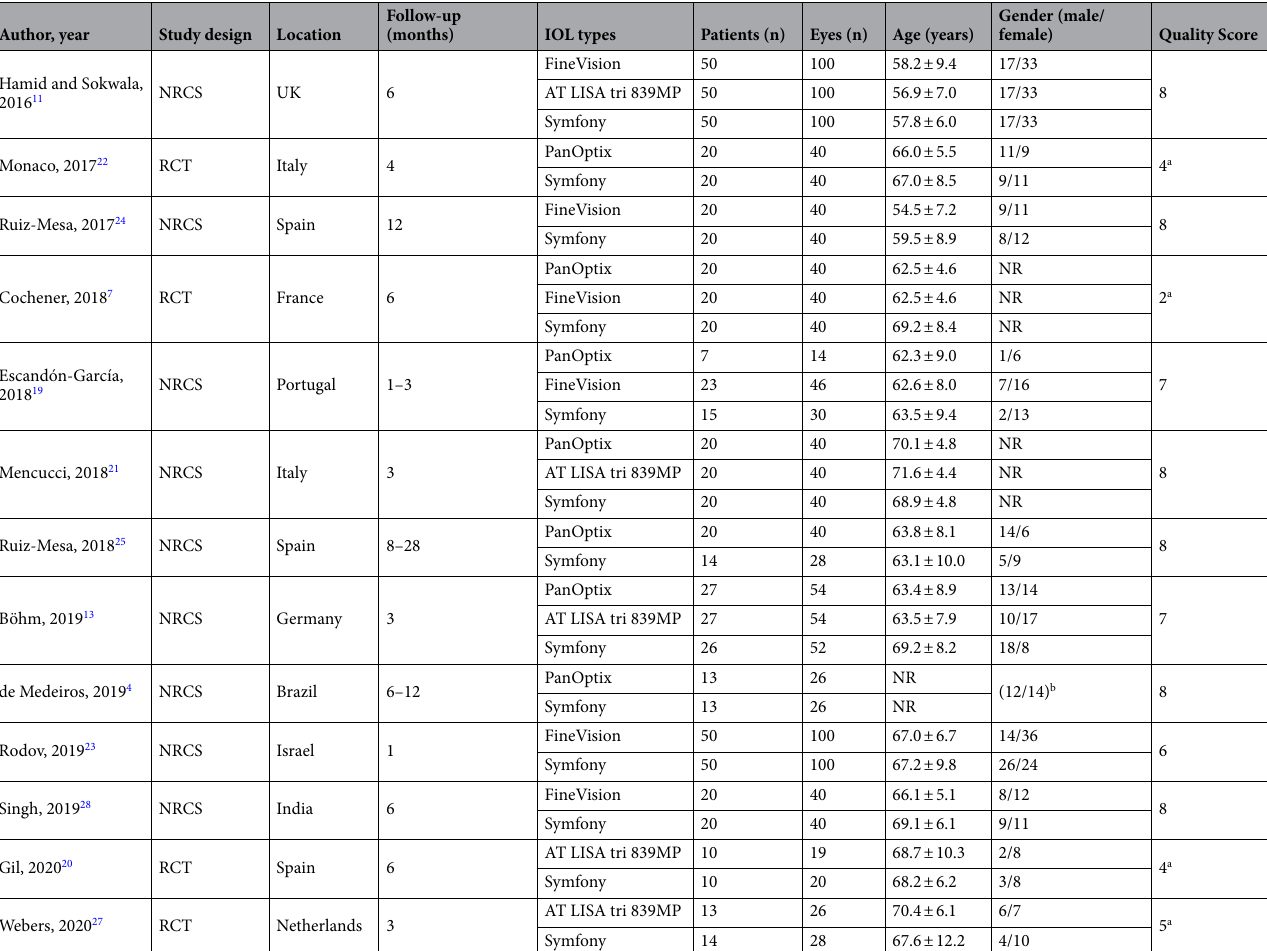
Table 1. Characteristics of the included studies comparing trifocal and the hybrid multifocal-extended depth of focus IOLs (n = 13). IOL, intraocular lens; RCT, randomized controlled trial; NRCS, non-randomized controlled study; NR, not reported. a RCTs assessed with the Jaded Scale. b The ratio for both groups, no separate data